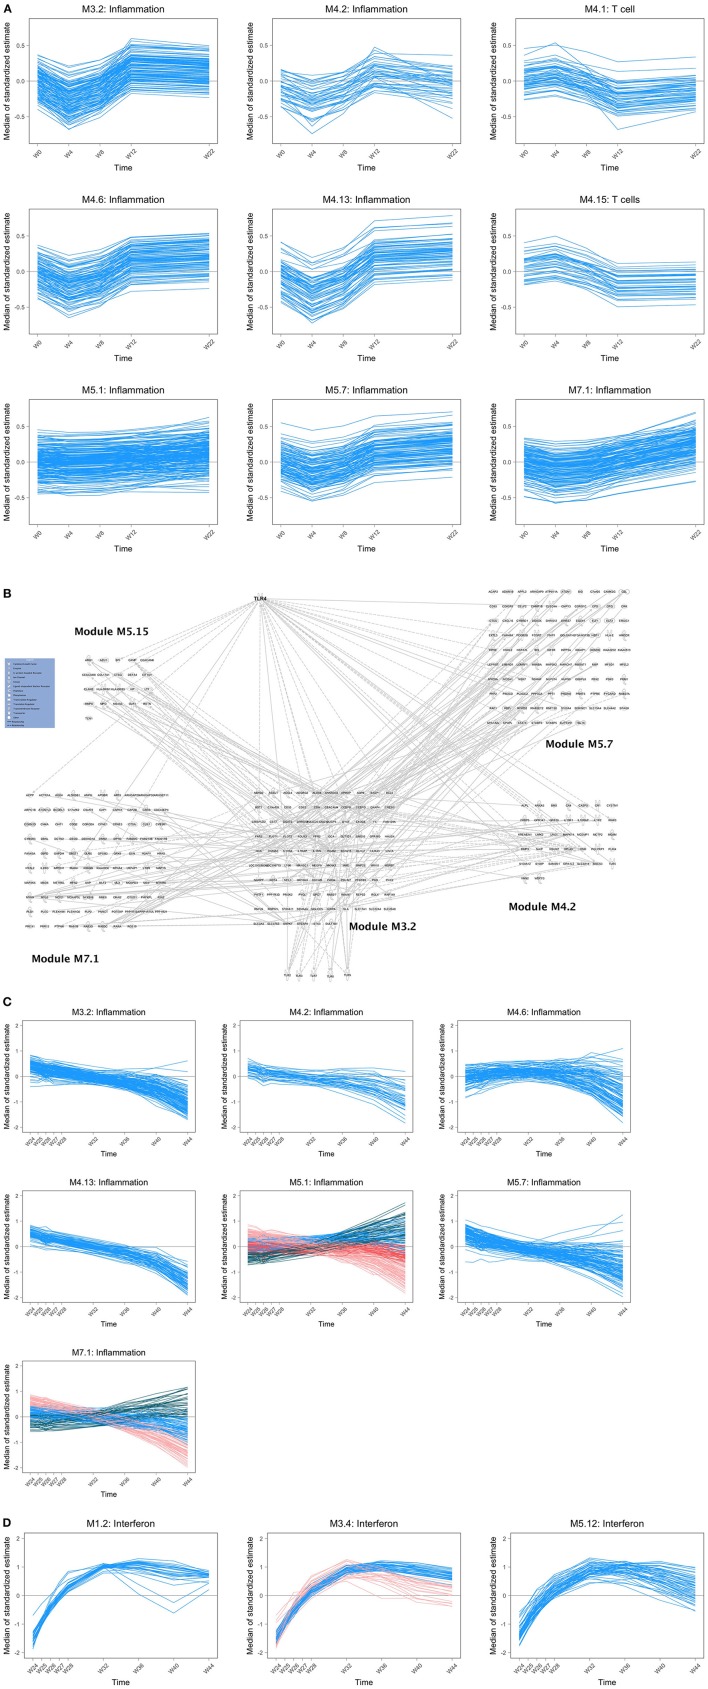
(A) Dynamics of gene abundance before antiretroviral treatment interruption. Dynamics of the gene abundance in various modules that changed significantly over time including inflammatory modules (M3.2, M4.13, M4.6, M5.7, M7.1, M4.2, M5.1) and T cell module (M4.1). Lines are smoothed trajectories predicted by the longitudinal statistical model (23). (B) Composition of inflammatory modules and relationship with TLRs. Relationships between inflammatory modules M3.2 and M4.2, M5.7, M7.1, and M5.15 (annotated “Neutrophils”) and TLR genes using Pathexplorer in IPA. Links between modules that are not concerning M3.2 are not represented. Links between inflammatory modules other than M3.2 and TLRs other than TLR4 are not represented. (C) Dynamics of gene abundance after antiretroviral treatment interruption: inflammatory modules. Dynamics of gene abundance in “inflammatory modules” that changed significantly over time. Various colors reflects different trajectories in the same modules defined by unsupervised clustering (23). (D) Dynamics of gene abundance after antiretroviral treatment interruption: interferon modules.